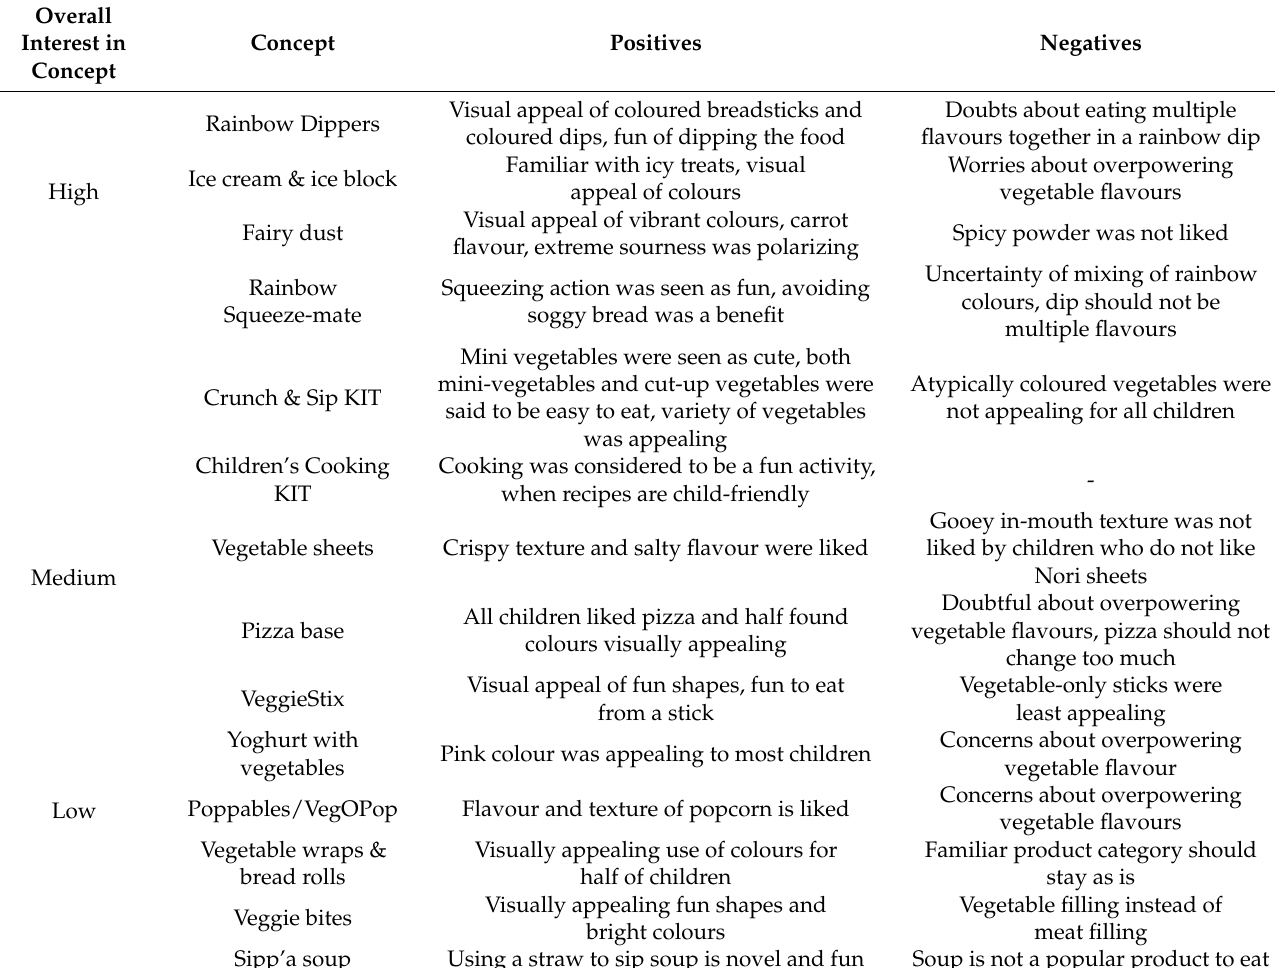
Table 3. Summary of children’s responses to concepts, with positives and negatives listed for each concept, shown with the overall interest in the concepts (high, medium, or low